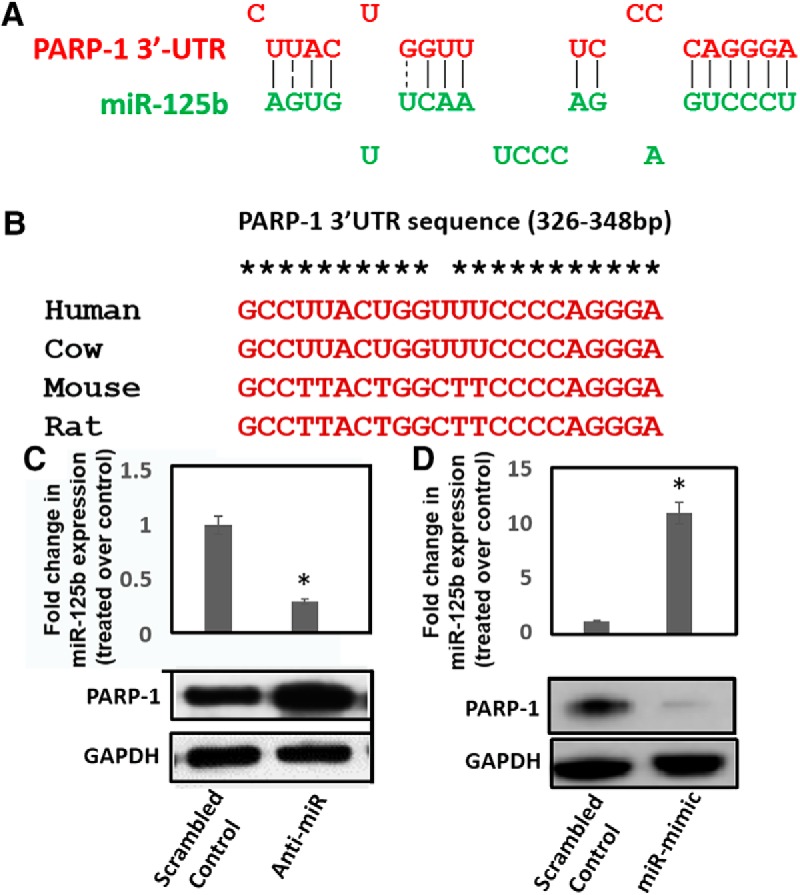
miR-125b expression negatively correlates with PARP-1 protein levels. A, In silico analysis predicts putative binding site of miR-125b in the 3’UTR of PARP-1 mRNA. B, Sequence alignment of miR-125b binding site in the 3’UTR of PARP-1 mRNA among different mammalian species. C, upper panel, miR-125b knockdown. Chemically synthesized anti-miR-125b oligonucleotides were transfected into differentiated SH-SY5Y cells and reduction of miR-125b expression was measured 24 h post-transfection by qPCR. C, lower panel, PARP-1 expression in miR-125b knocked-down cells was measured in the cellular lysates by immunoblot. D, upper panel, miR-125b overexpression. Chemically synthesized miR-125b mimic oligonucleotides were transfected into differentiated SH-SY5Y cells and miR-125b expression was measured 24 h post-transfection by qPCR. D, lower panel, PARP-1 expression in miR-125b overexpressing cells was measured in the cellular lysates by immunoblot. Data in C, D are representative of three independent experiments. *p < 0.05 for the comparison of anti-miR-125b or miR-125b mimic samples versus scrambled controls.